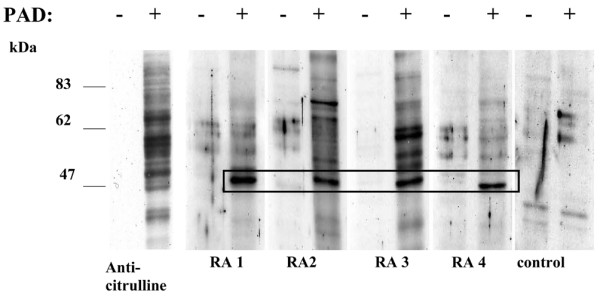
Screen to identify undeiminated and deiminated proteins reacting with RA and non-RA serum samples. Proteins from HL60 lysates incubated (+) or without (-) peptidylarginine deiminase (PAD) blotted with an antibody specific for modified citrulline residues (anti-citrulline) and a screening panel of rheumatoid arthritis (RA1 to RA4) and non-RA (control) serum. The rectangular box indicates a citrullinated protein reacting strongly with each of the RA serum samples but not the control.